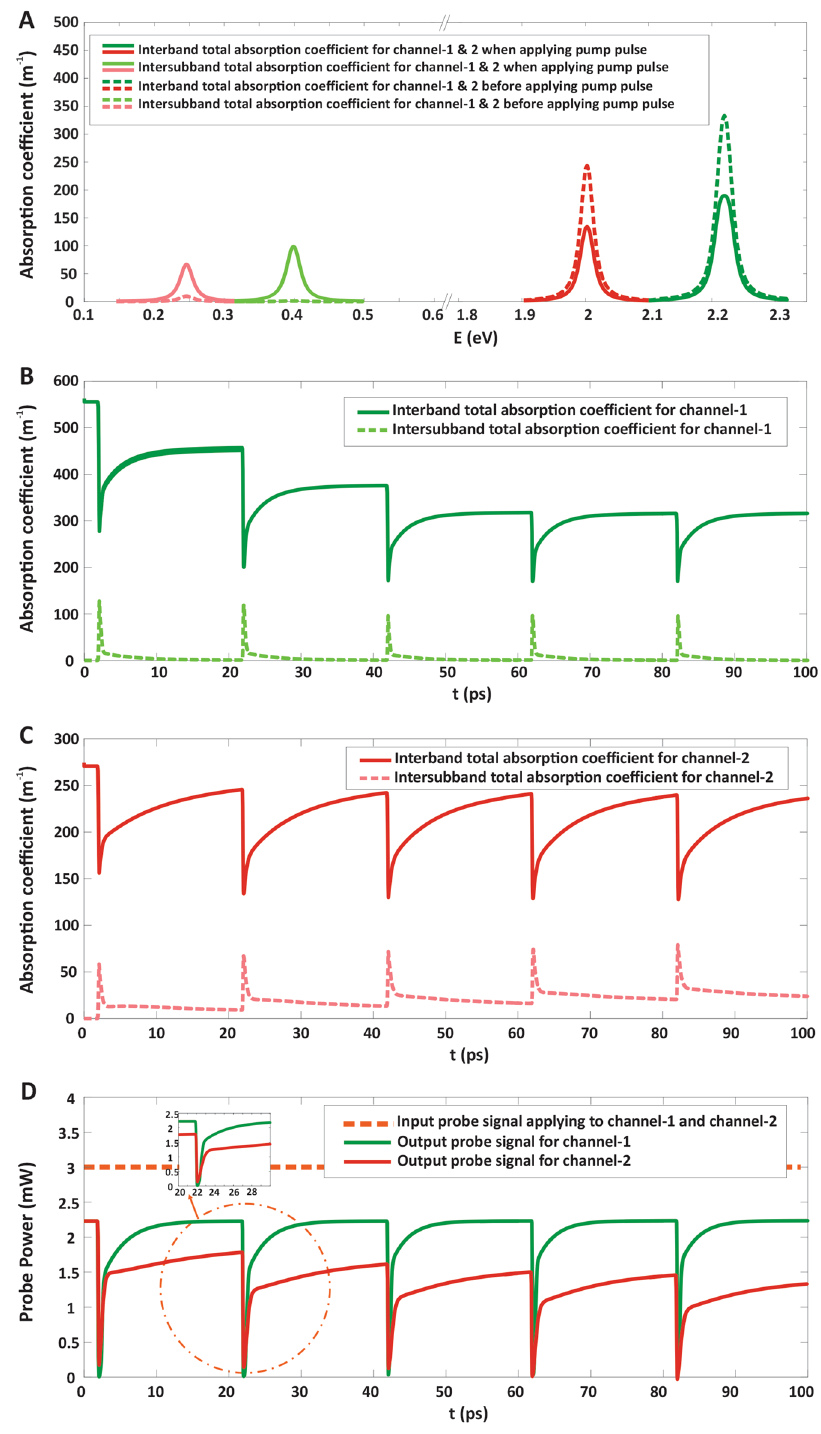
Figure 3. The performance of two-channel AOM. ( A ) The total interband and intersubban absorption coefficient spectrum for channel-1 and channel-2 before and after applying pump pulse, ( B ) and ( C ) Dynamics of the total interband and intersubband absorption coefficient for channel-1 and channel-2, respectively, ( D ) The output modulated probe power in which the input CW probe power is 3 mW for channel-1 and channel-2, by applying pump pulse train at frequency of 50